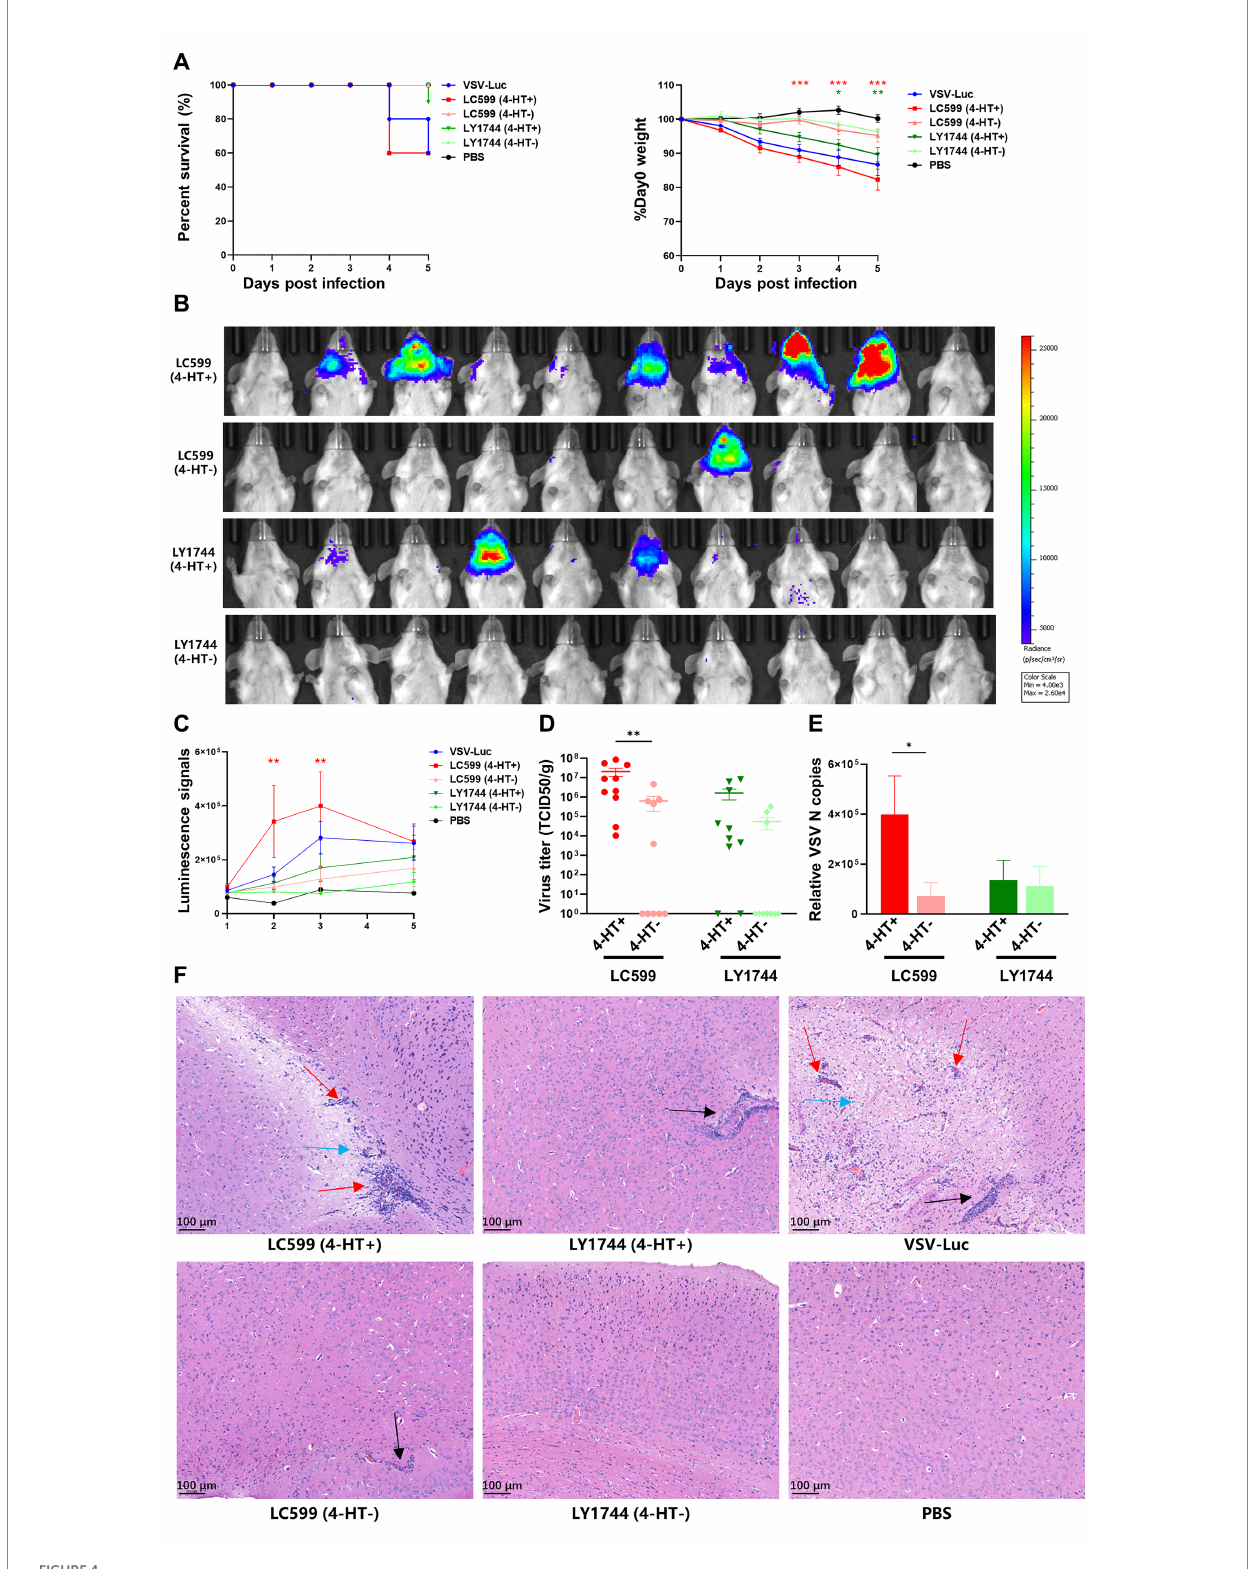
FIGURE 4 Characterization of the replication of the intern-modified VSV in mice. (A) Effect of intracranial (i.c.) virus infection with the indicated viruses on the survival rates and body weights of BALB/c mice ( n = 10). (B) Luminescence imaging in challenged mice on day 3. Luminescence intensity (photons/s/ cm2/sr) was represented in false colors. (C) Changes of the whole-brain luminescence signals. (D) Detection of the virus titers in the brain tissues of a mouse ( n = 10) on day 5. (E) Viral RNA transcripts of N genes in the brain (5 dpi) were measured by quantitative real-time PCR. Data were plotted for individual mice ( n = 10). (F) Representative brain sections were isolated on day 5 after the challenge of mice. Brain sections were stained with hematoxylin and eosin (HE), original magnification 10×. Lymphocyte infiltration (blue arrow), perivascular cuffing (red arrow), and lymphocyte aggregation (blue arrow). Significance of results were evaluated by Mann Whitney test between two groups. p value less than 0.05 was considered significant. * p < 0.05; ** p < 0.01; *** p < 0.001; n.s., not